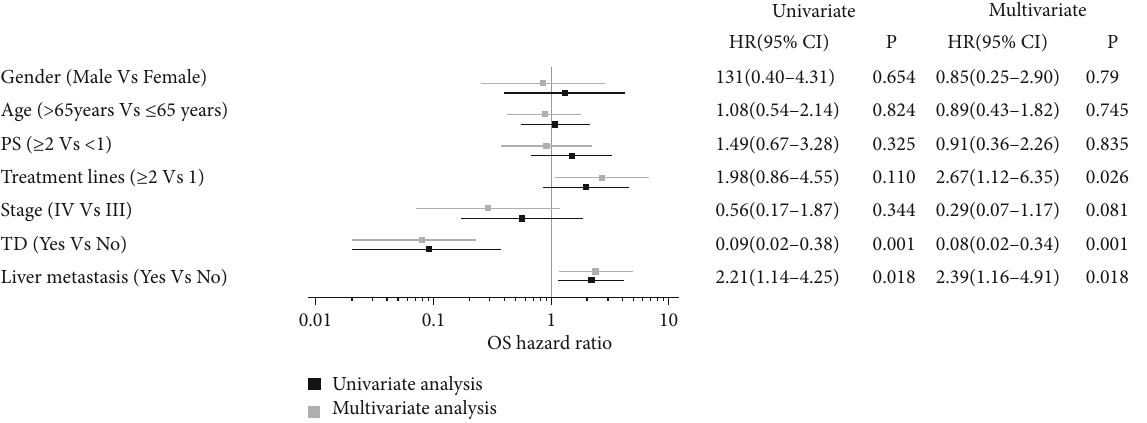
Figure 4: Prognostic factors for OS by univariate and multivariate analysis in ESCC patients received